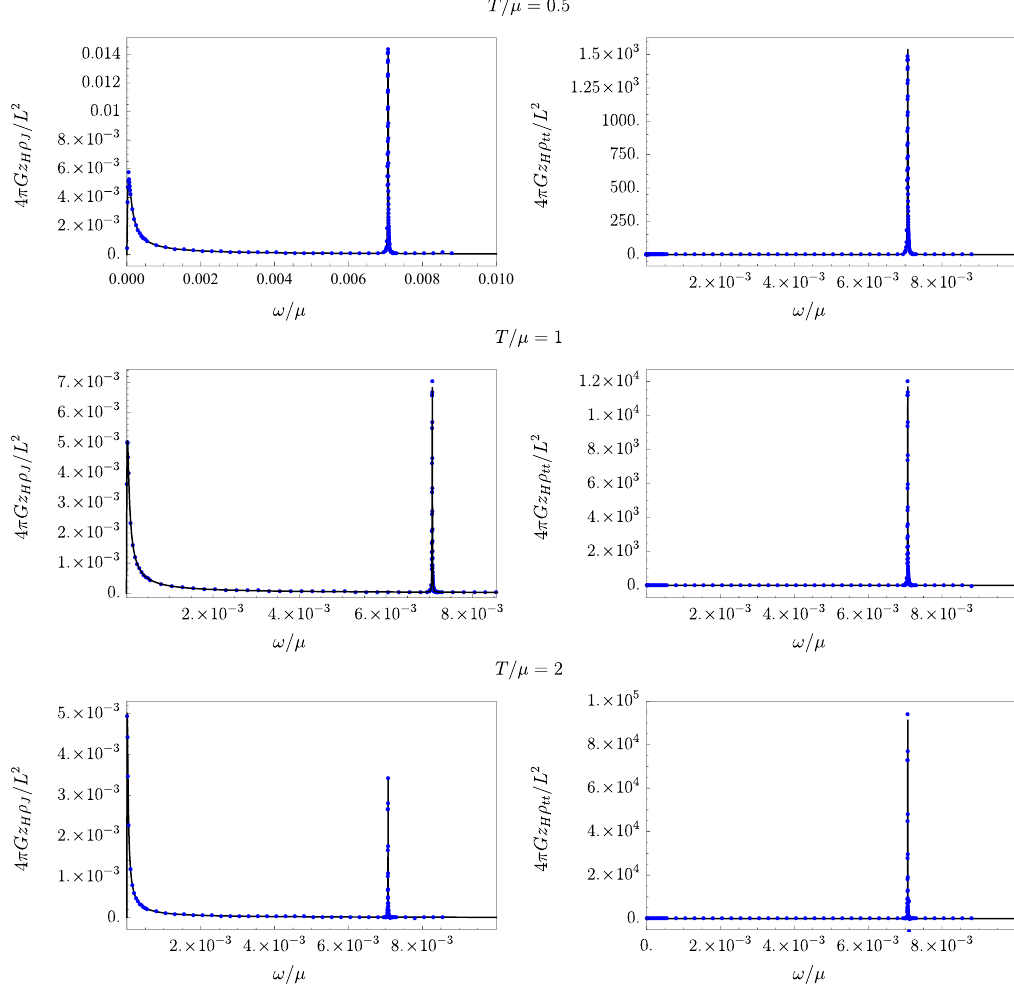
Figure 15. Our numerical results (blue dots) for the charge spectral function, (cid:26) J (left column) and energy spectral function, (cid:26) tt (right column), each made dimensionless by a factor of 4 (cid:25)Gz H =L 2 , as functions of !=(cid:22) for (cid:28) = 10 (cid:0) 2 , ~ (cid:11) = 1, k=(cid:22) = 10 (cid:0) 2 and T=(cid:22) = 0 : 5 (top row), 1 (middle row), and 2 (bottom row). The solid black lines come from the sum-of-poles approximation to the Green’s functions in eq. (3.6). As T=(cid:22) increases, the behaviors of both (cid:26) J and (cid:26) tt are similar to the (cid:28) = 10 (cid:0) 4 and 10 (cid:0) 3 cases in (cid:12)gures 13 and 14: in (cid:26) J the sound peak shrinks while the charge di(cid:11)usion